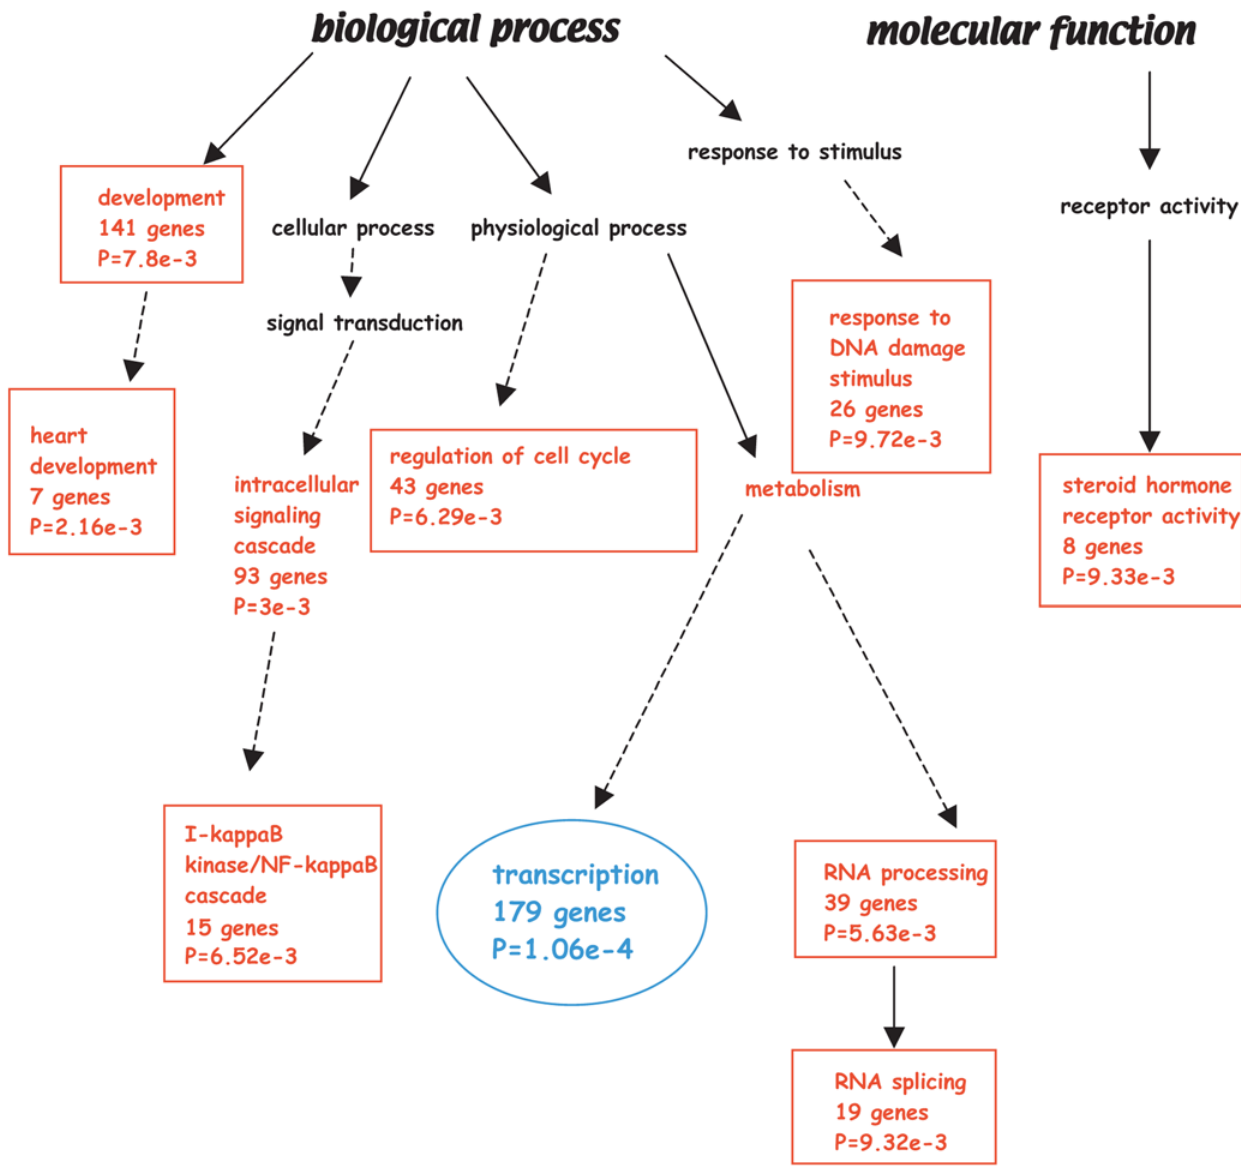
Figure 1. GO enrichment tree of p63 targets. Selected enriched GO categories and their respective number of genes with associated p values are depicted in red. Scheme adapted from Figure S1.